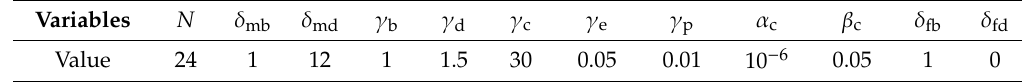
Table 4. Non-dimensional parameters of the